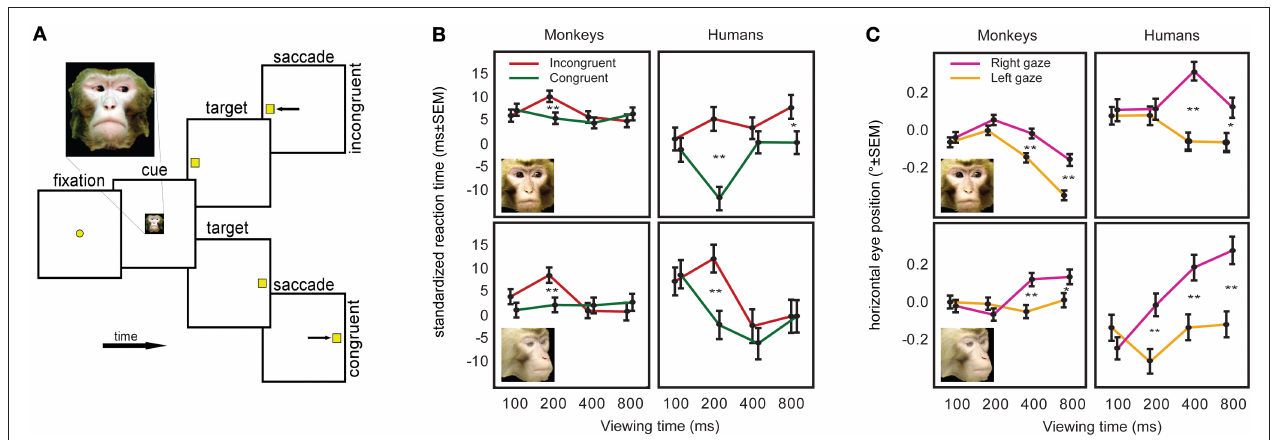
FIgure 5 | Anthropoids primates follow gaze with similar sub-second dynamics. (A) Monkeys and humans performed an identical task, in which they fixated a central face gazing left or right, and then looked toward a peripheral target. The target was not predicted by the gaze direction of the cue. (B) Monkeys and humans were faster to look toward targets appearing in the